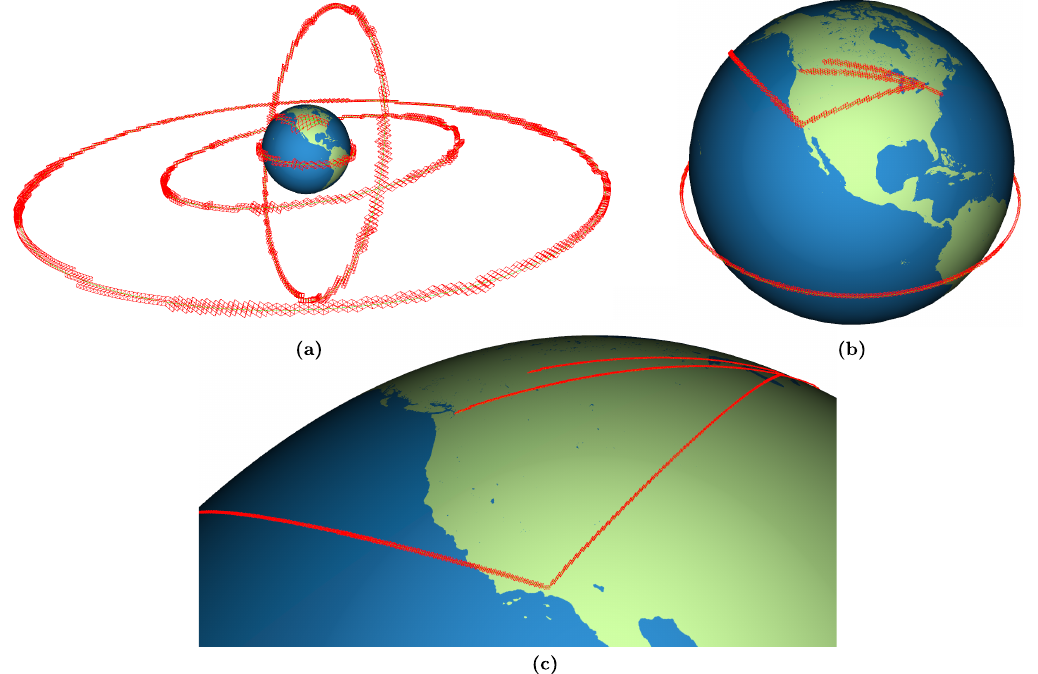
Figure 13. Flight paths and satellite orbits rasterized in a 3D DGGS. All paths and orbits are rasterized at the same grid resolution of ( a ) 7, ( b ) 10, and ( c )